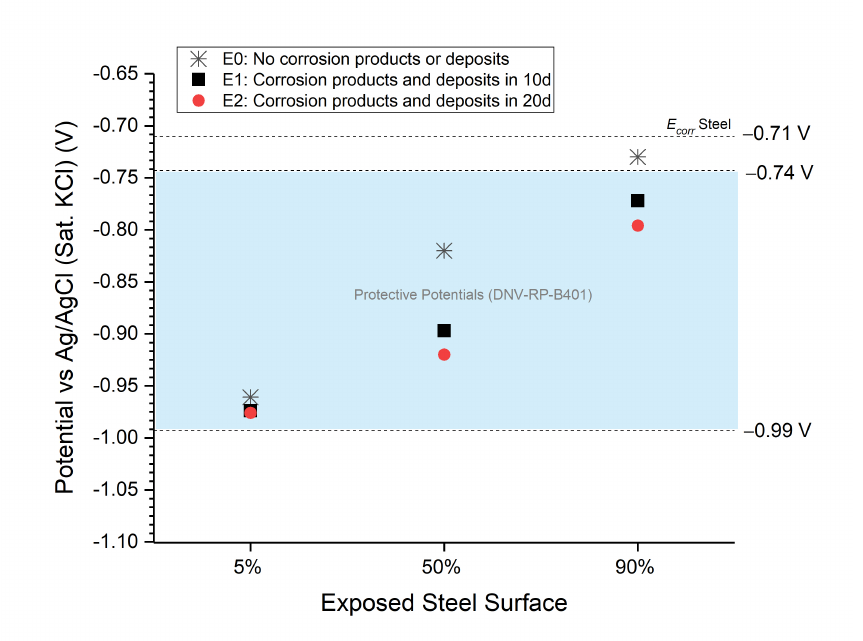
Figure 2. Simulated potential as a function of the exposed steel surface and combined effect of corrosion products and